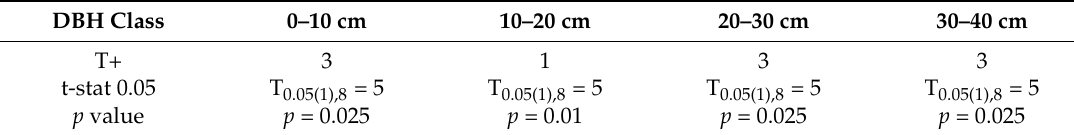
Table 2. Results for Wilcoxon paired-sample one-tailed T test run on ponderosa